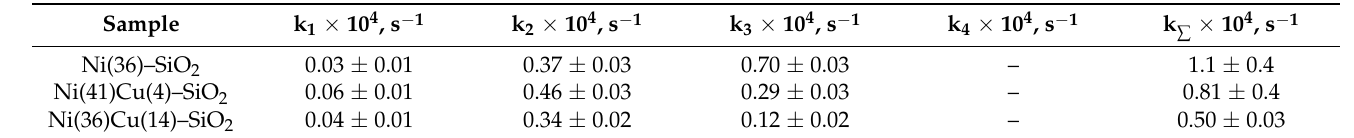
Table 3. Rate constants of product formation in the experiments at 150 ◦ C. The constants were calculated using the least squares method, m(catalyst) = 0.36–0.37 g.